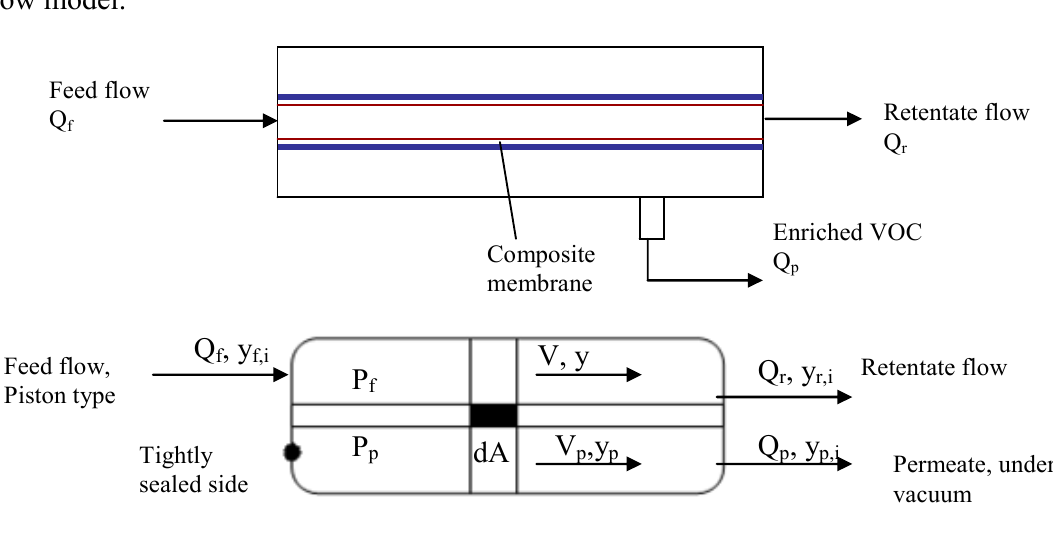
Figure 4. Schematic diagram of the membrane process (top) and differential unit of the membrane (bottom) for the volatile organic compound (VOC) separation based on piston flow